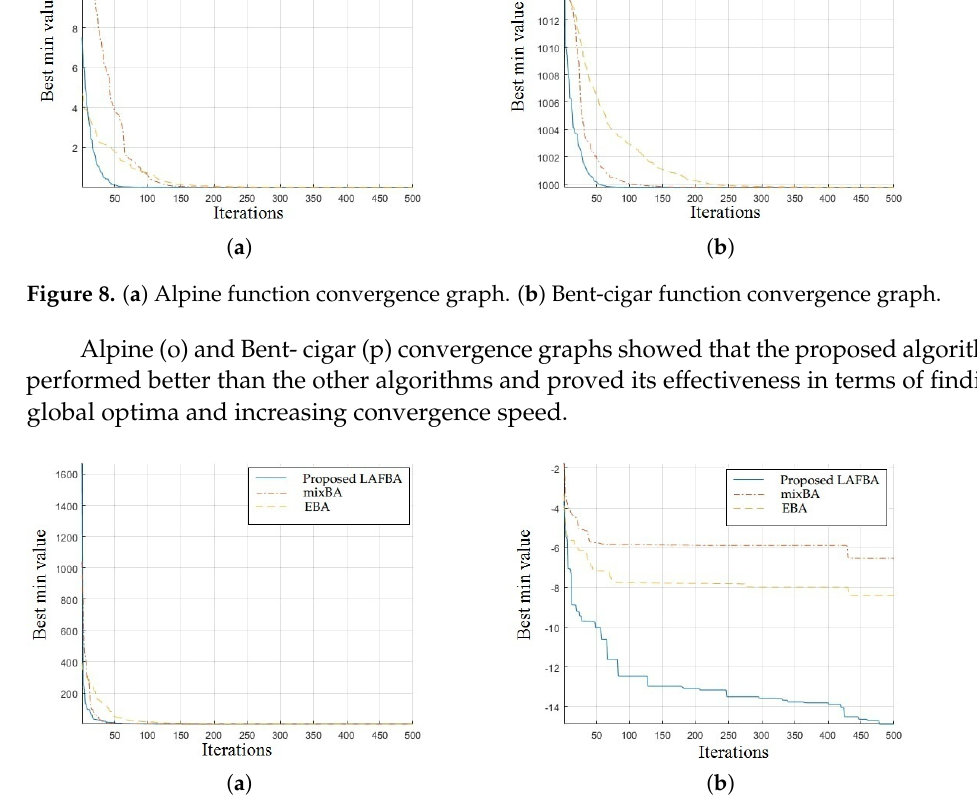
Figure 9. ( a ) Dixon–Price function convergence graph. ( b ) Michalewicz function convergence graph. The convergence graphs of the Dixon–Price (q) and Michalewicz functions (r) demon-